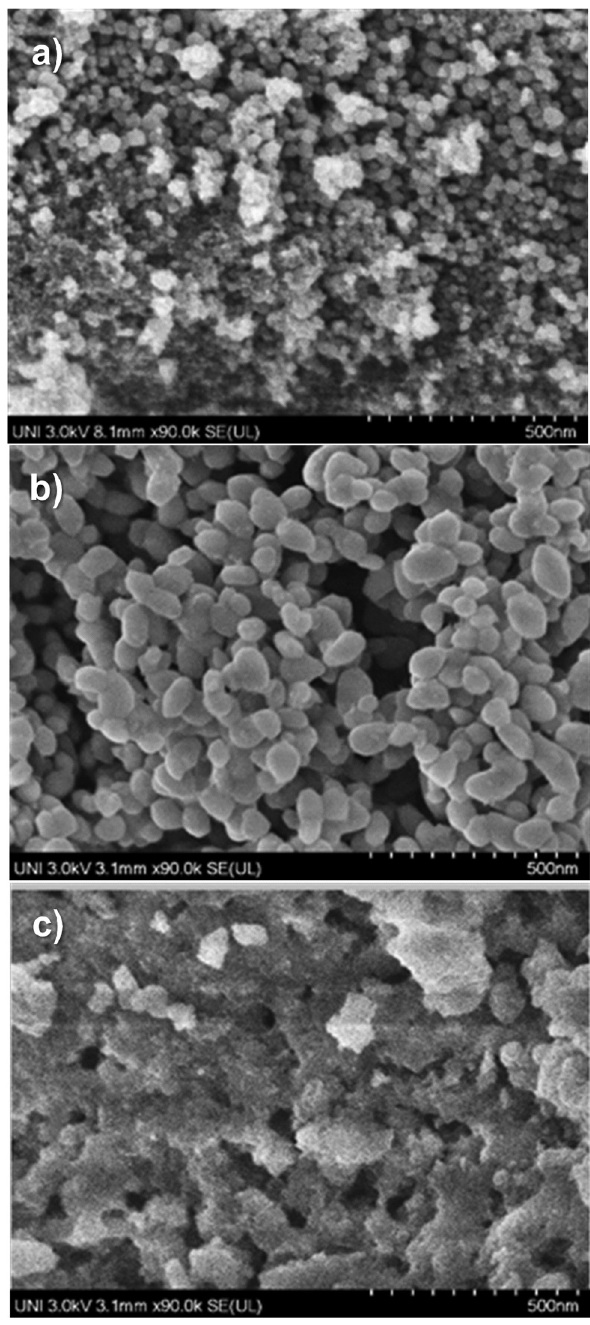
Figure 1: SEM images for the three iron oxides: ( a ) magnetite, ( b ) hematite, and ( c ) a - FeOOH.